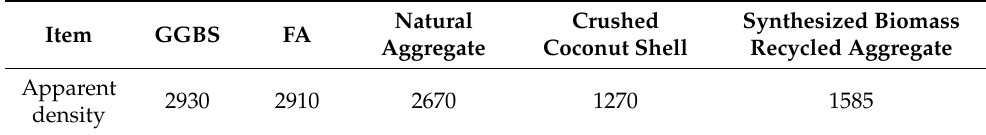
Figure 3. ( a ) Hardening and molding process of recycled coarse aggregate of synthesized biomass. ( b ) Synthesized biomass regenerated coarse aggregate. Table 4. Apparent density of different raw materials (kg/m 3 ).